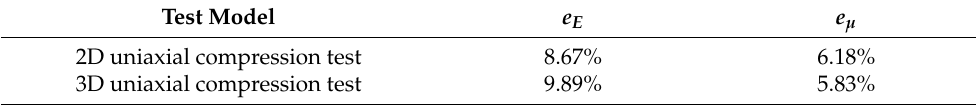
Table 3. Inversion error of Young’s modulus field and Poisson ratio field of Scheme